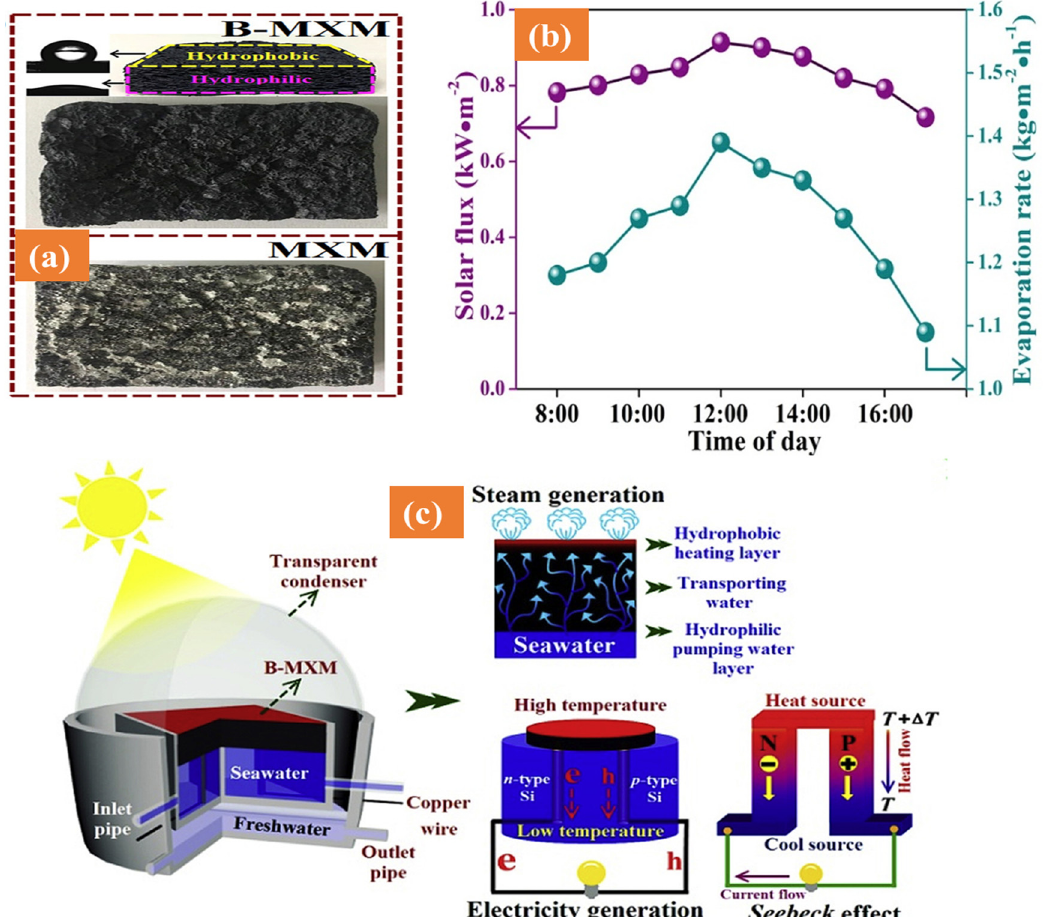
Figure 6. ( a ) Hydrophobic/hydrophilic bilayers of Ti 3 C 2 MXene-based monolith with heat localization by hydrophobic nature, ( b ) corresponding evaporation rate at various time and solar intensities, and ( c ) implementation of simultaneous solar desalination and voltage measurements through temperature difference, using hydrophobic and hydrophilic Ti 3 C 2 MXene layers (reprinted from Ref. [20], copyright with permission from Elsevier, 2020).